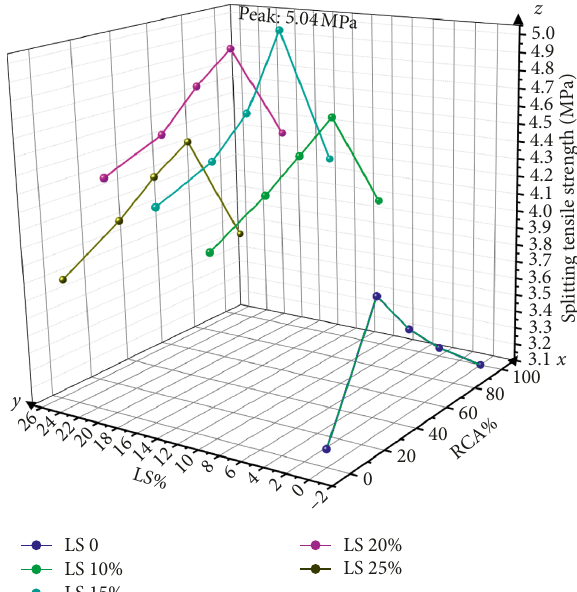
Figure 4: The effect of RCA and LS on the splitting tensile strength.